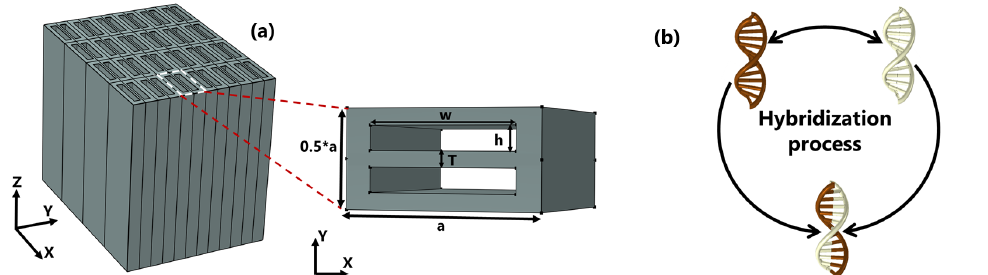
Figure 1. ( a ) Schematic design of a three-dimensional array and an in-plane overview of the dimer PhC with a period of a = 1 µ m; w = 750 nm and h = 125 nm are the width and height, respectively; T is gap spacing ranging from 100 to 30 nm. ( b ) An illustration of the hybridization process of two single DNAs